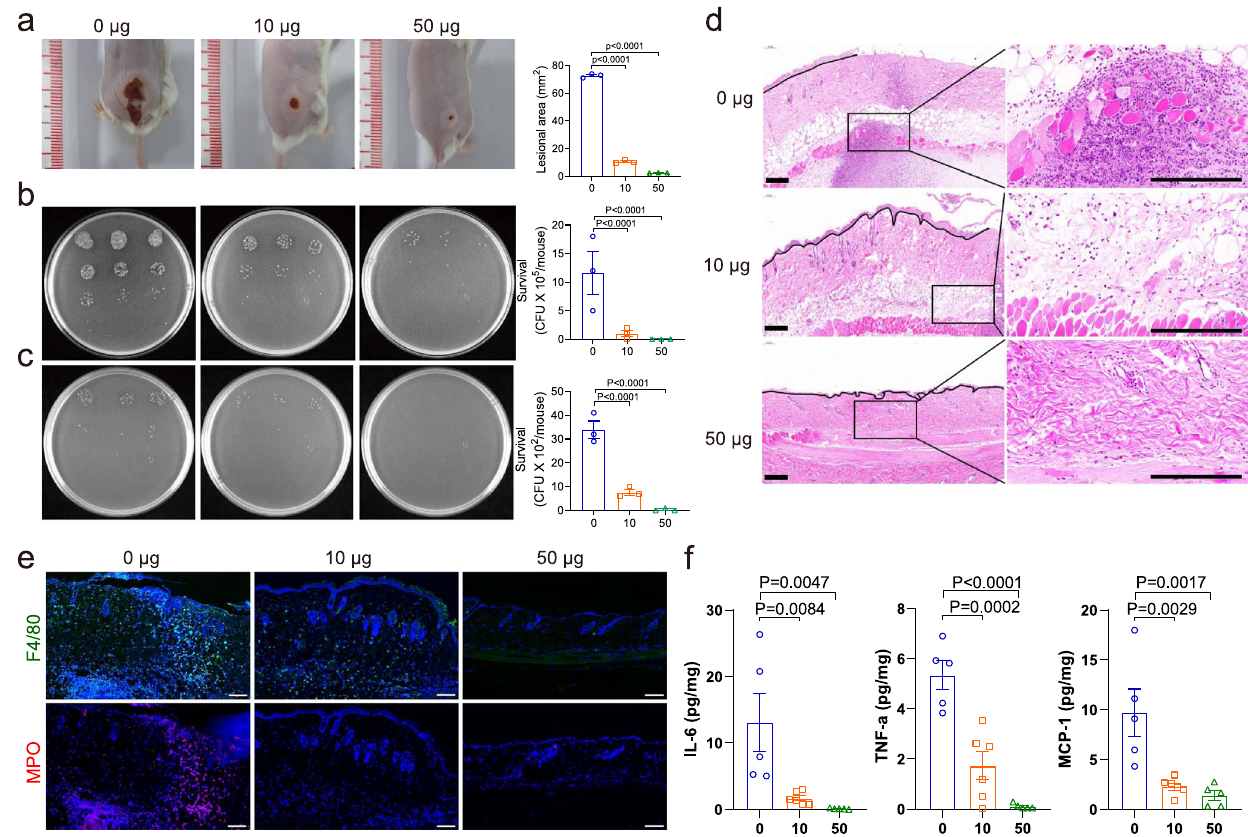
Fig. 6 | Nano-MgB 2 inhibited skin infection in vivo. a Photographs of P. aerugi- nosa -infectedmouseskintreatedwithorwithout10 μ gand50 μ gNano-MgB 2 ( n =3 biologically independent mice). b , c Survival of bacteria from P. aeruginosa -infec- ted mouse skin or spleen taken as in ( a ) ( n =3 biologically independent mice). d H&E staining of P. aeruginosa -infected mouse skin taken as in ( a ). Scale bar= 200 μ m. e Immuno fl uorescence staining with the neutrophil cell marker myelo- peroxidase (MPO) and macrophage cell marker F4/80 of P. aeruginosa -infected